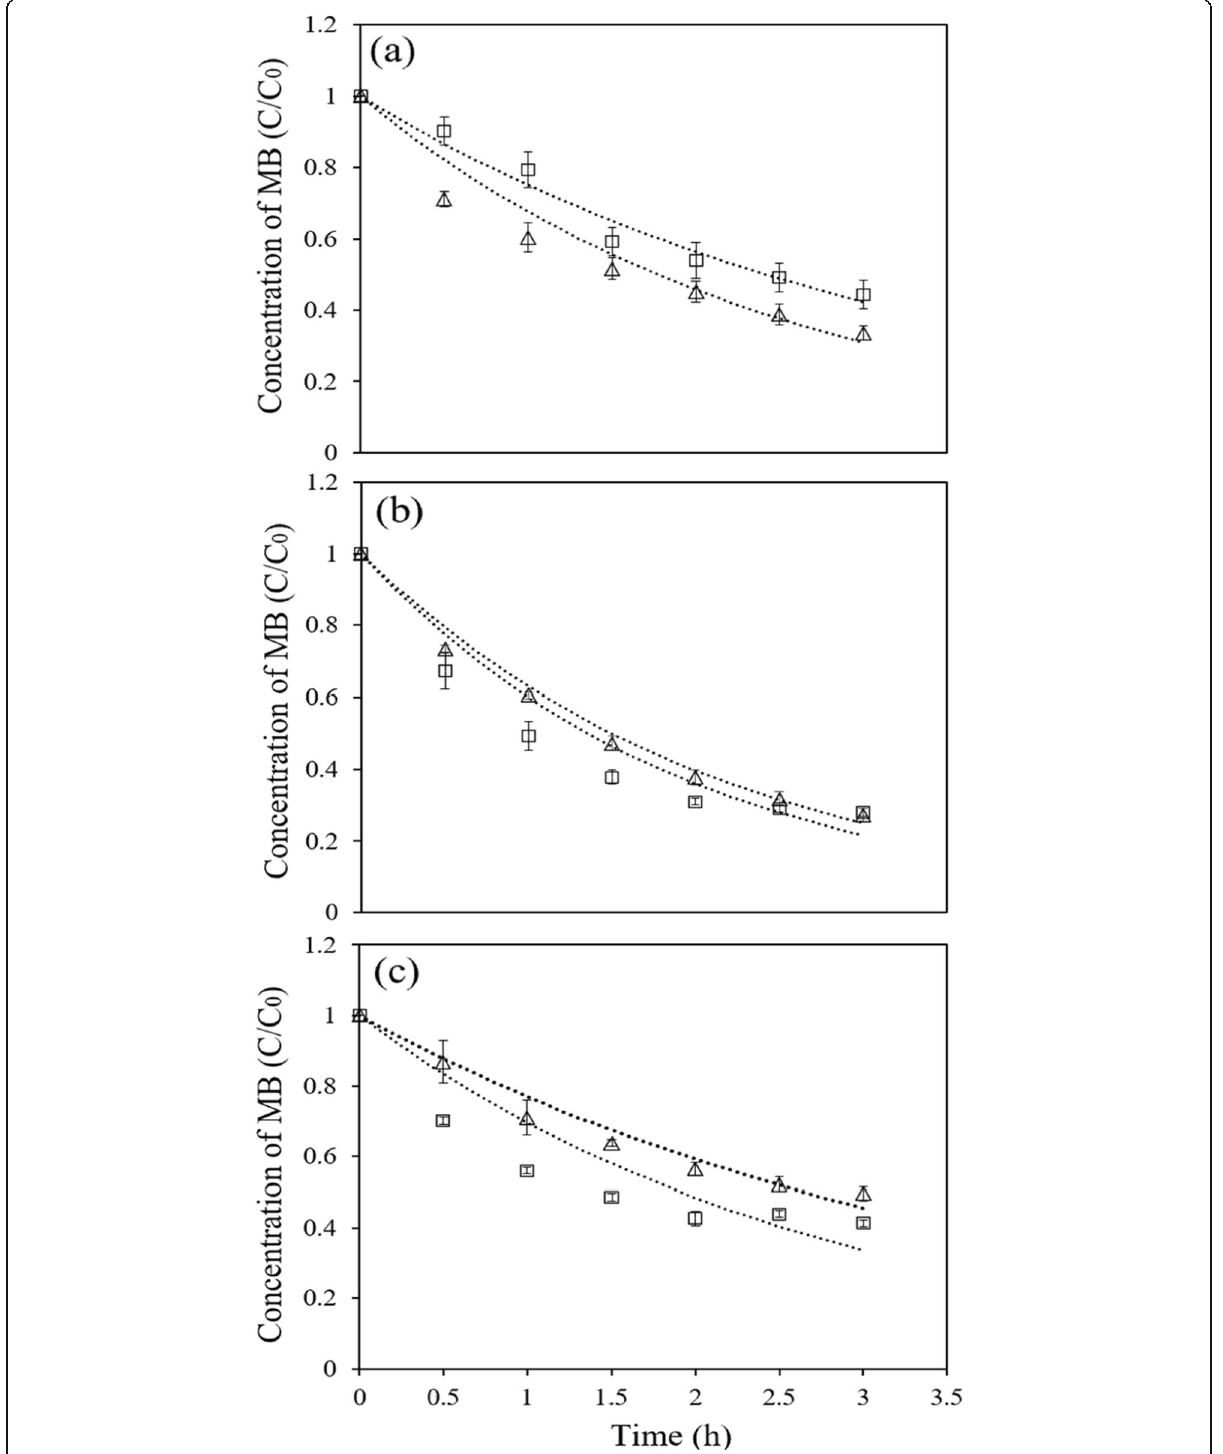
Fig. 7 Electrochemical degradation efficiency of MB in solution by using CNTs/CF M as both cathode and anode under various electrolytes and applied currents of A 10, B 50, and C 100 mA. □ : 0.1 M KHCO 3 ; Δ : 0.1 M H 2 SO 4 . Initial MB concentration of 10 mg L − 1 , initial pH value of the solution of 8.19 and 1.83 for 0.1 M KHCO 3 and 0.1 M H 2 SO 4 ,